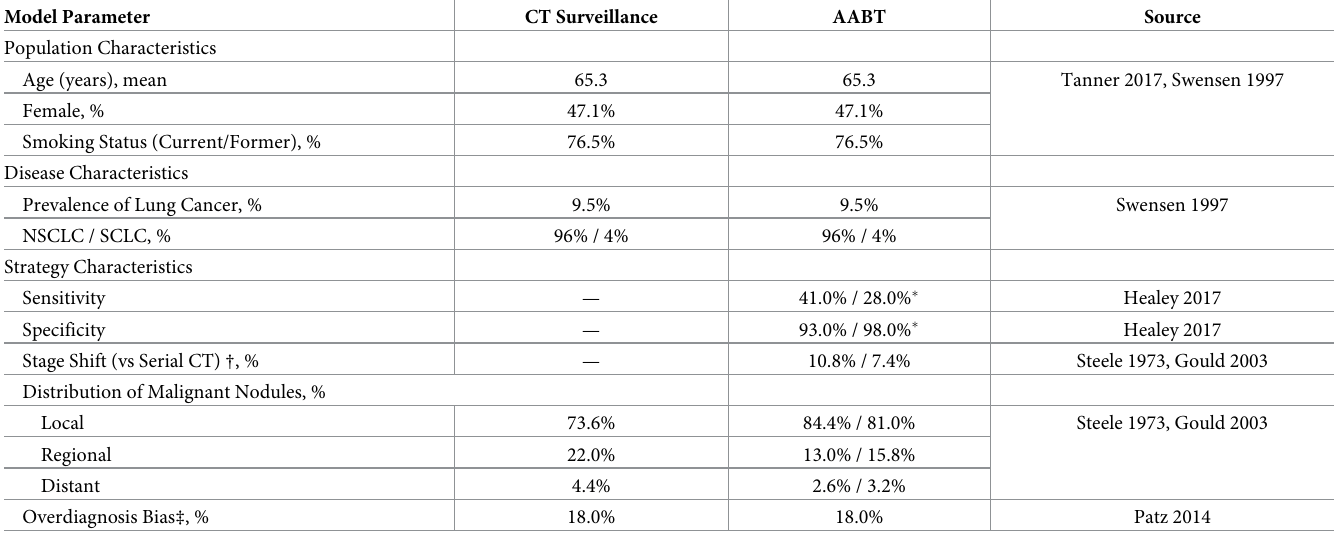
Table 1. Population, disease, and strategy characteristics for patients who have incidentally detected pulmonary nodules, are at intermediate risk, and were sched- uled for CT surveillance alone. Model Parameter CT